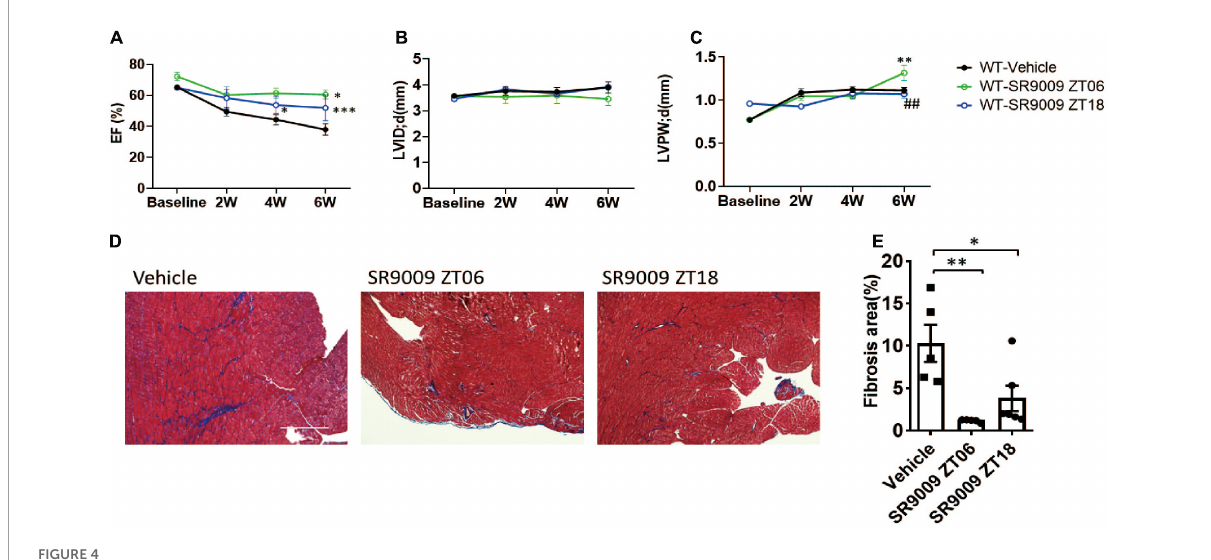
FIGURE4 Post-TAC SR9009 treatment at ZT6 or ZT18 is equally cardioprotective. (A–C) Echocardiography analysis of time-dependent effect of SR9009 on cardiac functions in WT TAC mice. WT-vehicle n = 10, WT-SR9009 ZT06 n = 6, WT-SR9009 ZT18 n = 5. Data are shown as mean ± S.E.M. ## p < 0.01 by two-way ANOVA comparing to the WT-SR9009 ZT18 group, ∗ P < 0.05, ∗∗ p < 0.01, ∗∗∗ P < 0.001 by two-way ANOVA comparing to the WT vehicle group. Tukey’s test was used for multiple comparison corrections. (D,E) Representative images and quantification of fibrosis area by Masson’s trichrome staining at 6 weeks after TAC. ∗ P < 0.05, ∗∗ p < 0.01 by one-way ANOVA. Tukey’s test was used for multiple comparison